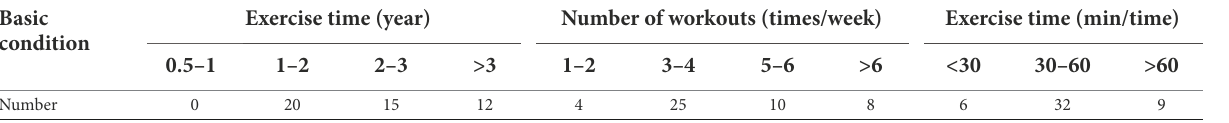
TABLE 4 Questionnaire about the square dance exercise of the silver hair nationality.